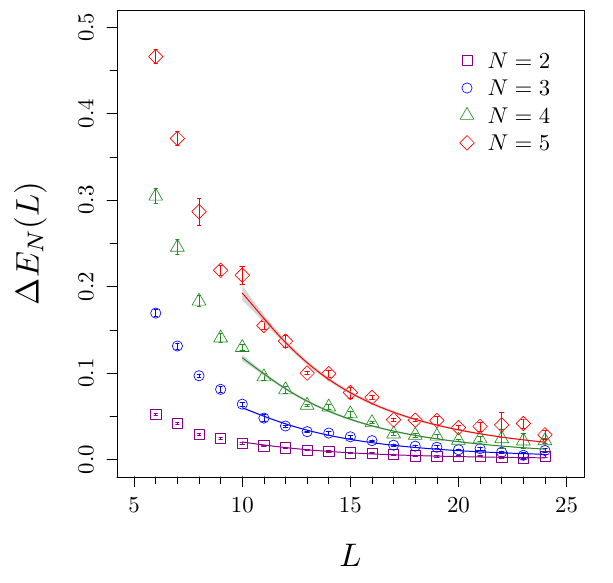
Figure 8. Global fit without priors in the interval [10 , 24] for L . Both EC and RC are